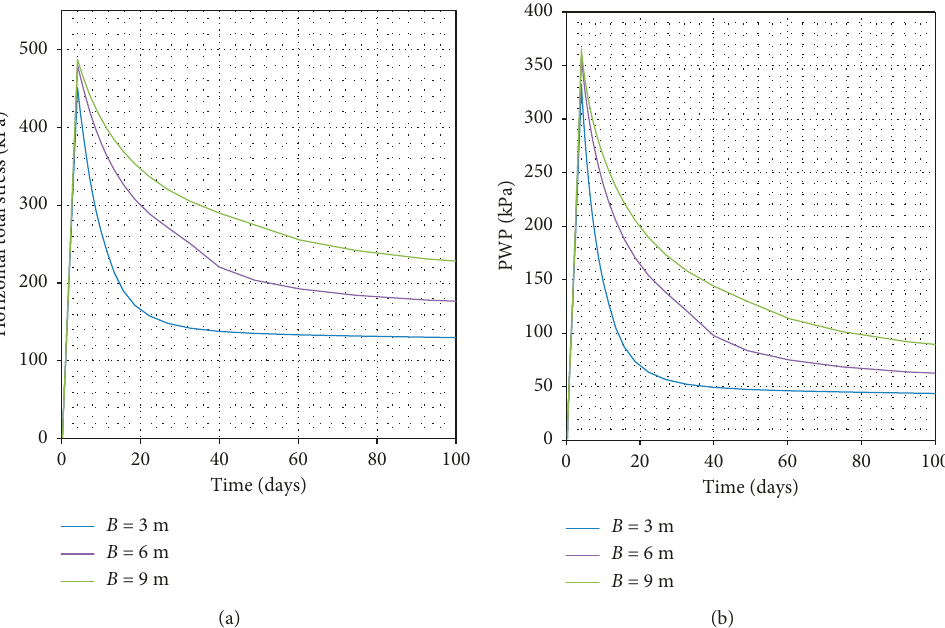
Figure 9: Evolution of (a) σ h and (b) u w on the barricade at midheight of the drift for three different stope widths (see the details in Table 1, Case